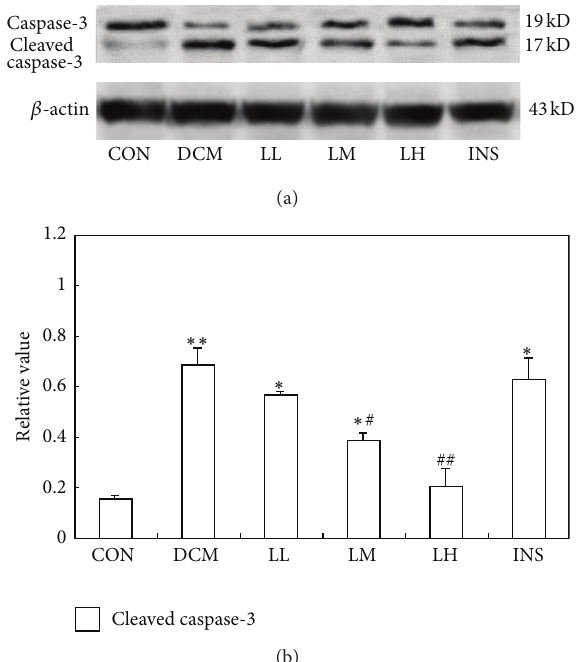
Figure 2: Effects of LIRA on the activation of caspase-3 in the DCMandCON.(a)Westernblotwasperformedusingeachrelevant antibody. 𝛽 -actin was shown as a loading control. (b) Statistical analysis. Data were shown as mean ± S.D. ∗ 𝑃 < 0.05 and ∗∗ 𝑃 < 0.01 versus CON rats, # 𝑃 < 0.05 , and ## 𝑃 < 0.01 versus DCM rats.